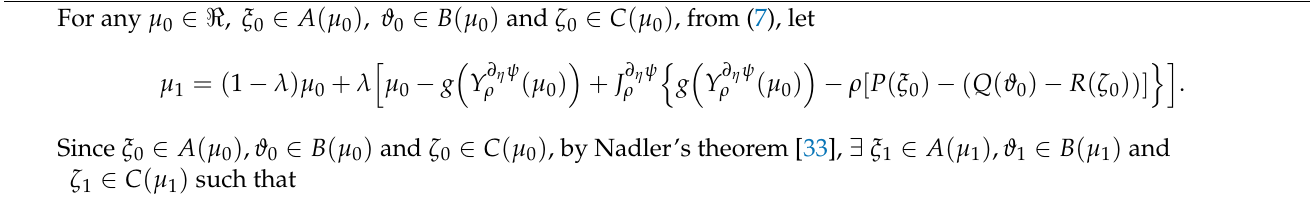
Algorithm 1: Iterative